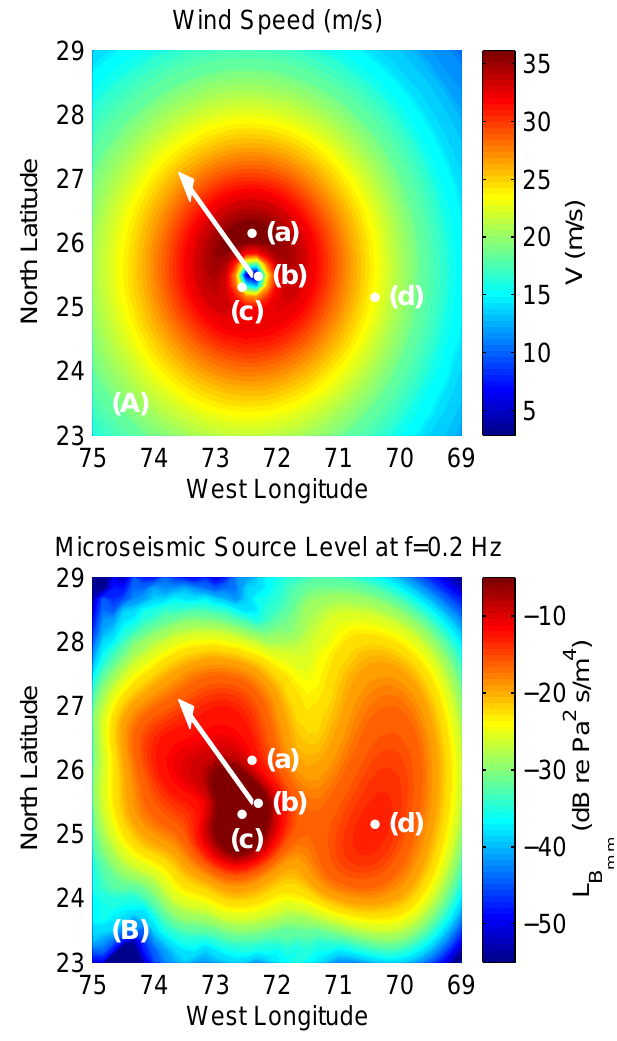
( ω , z s = 0 ) at ω = 1.26 rad/s Figure 1. ( A ) Wind speed in m/s and ( B ) microseismic source level L B mm ( f = 0.2 Hz) in dB re Pa 2 s/m 4 from Equation (39) at 1200 on 24 August 1998 as a function of latitude and longitude. The arrow indicates the direction hurricane Bonnie was moving. The letters (a–d) represent features of interest; (a) indicates the location of maximum wind speed, (b) indicates the eye where wind speed is zero, and (c,d) indicate peaks in the microseismic source level. This figure shows that, while a hurricane can produce significant microseismic source levels ( B ), these level do not directly follow the wind speeds ( A ) in the